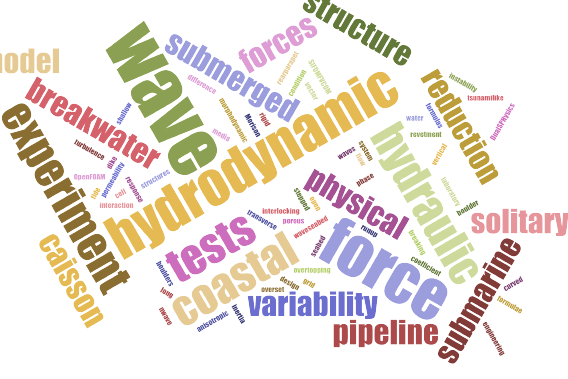
Figure 1. Word cloud of the keywords published in the papers of this Special Issue. An overview of the contributions of the Special Issue is here carried